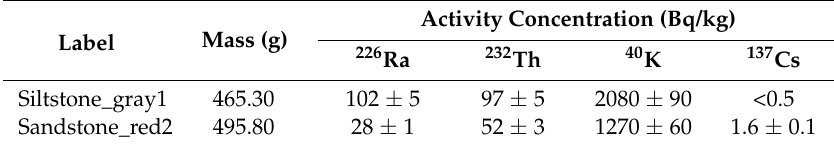
Table 7. Radioactivity of characteristic samples from “Multicolored Series” sediments.